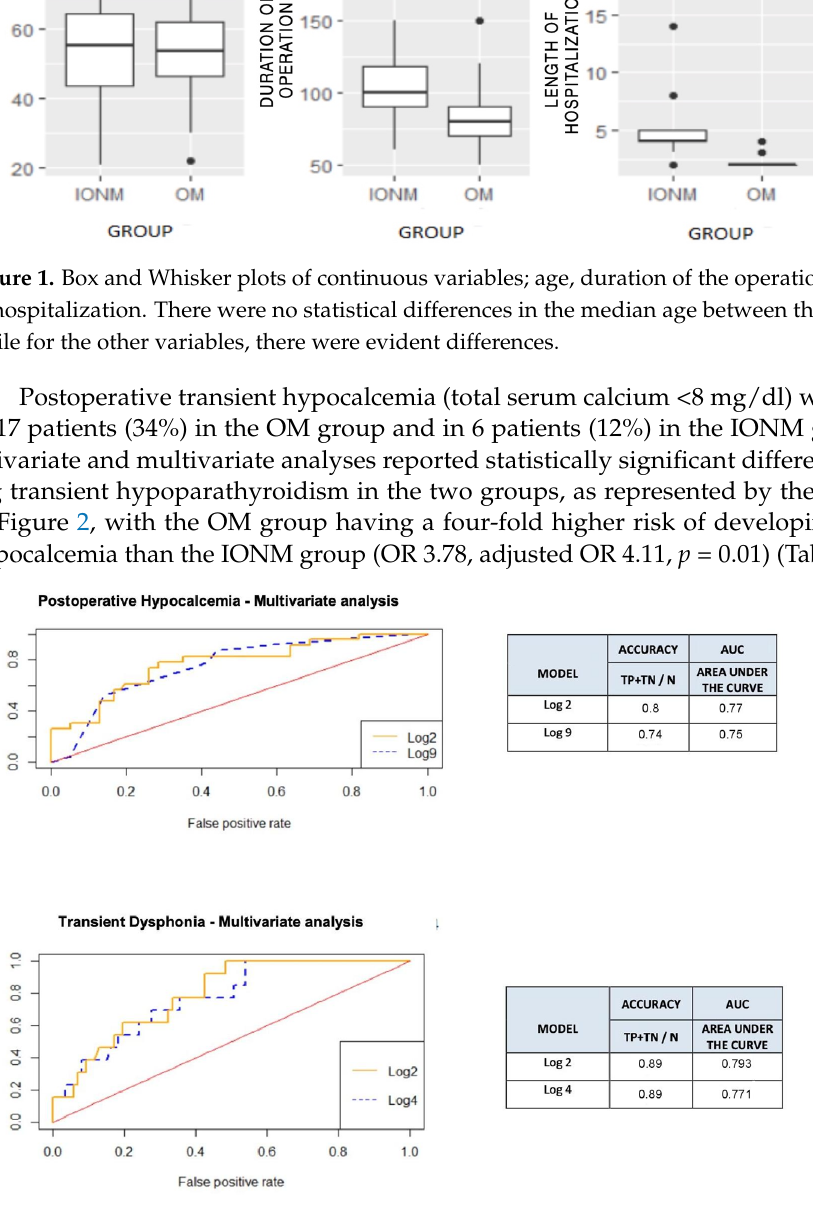
Figure 2. ROC curves and accuracy of the multivariate analysis of the transient postoperative hypocal- cemia and transient dysphonia outcomes. The most appropriate logistic models were extrapolated through backward analysis, and compared with those models including more or fewer variables but with similar statistical significances. For both outcomes, the Log2 model reported a higher accuracy and was chosen for the analysis.